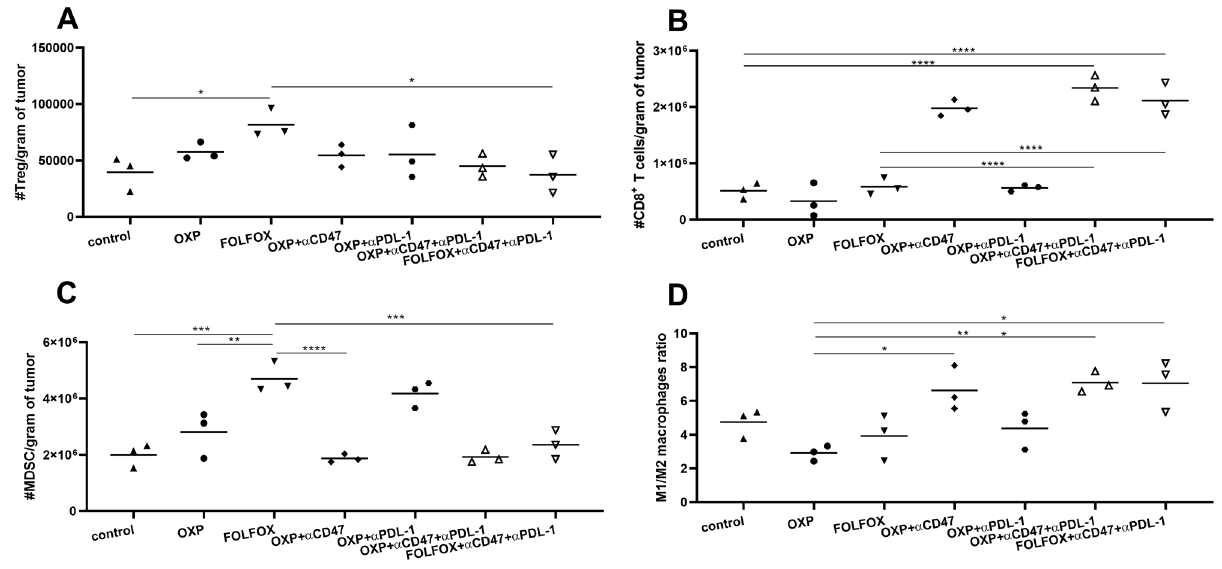
Figure 5. Immune cell analysis in the tumor microenvironment of mice bearing CT-26 tumor. ( A ) Treg number per gram of tumor. Treg number increased in tumor microenvironment following treatment with both OXP and FOLFOX regimen, however, it was only significant in FOLFOX receiving group. Combining anti-CD47 and anti-PD-L1 with FOFOX leads to a significant decrease in Treg per gram of tumor compared to mice receiving FOLFOX alone. ( B ) CD8 + Tcells number per gram of tumor. OXP and FOLFOX and FOLFOX didn’t change, CD8 + Tcells number, but in groups which received anti-CD47 as part of their treatment CD8 + T cells number per gram of tumor increased significantly. ( C ) MDSC number per gram of tumor. ( C ) OXP, and FOLFOX increased MDSC number however it was only significant in FOLFOX receiving group when we added anti-CD47 in the combining regimen, it leads to a significant decrease in MDSC number compared to mice receiving OXP, FOLFOX and OXP + PD-L1. D, M1/M2 macrophage ratio in the tumor microenvironment. Adding anti-CD47 to the combining regimens, increase the M1/M2 macrophage ratio compared to other